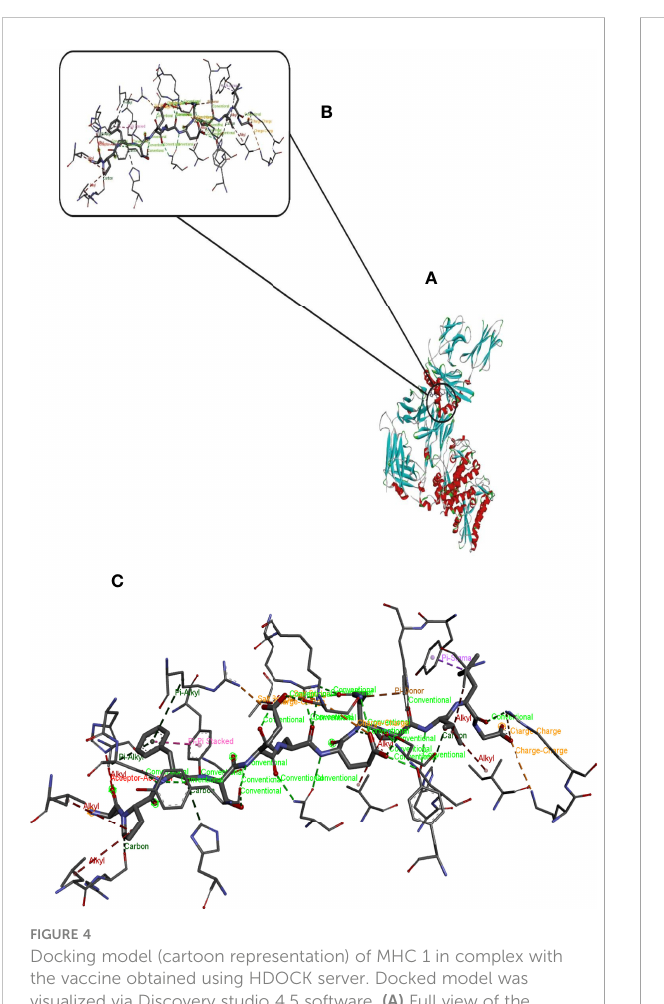
FIGURE 4 Docking model (cartoon representation) of MHC 1 in complex with the vaccine obtained using HDOCK server. Docked model was visualized via Discovery studio 4.5 software. (A) Full view of the docked model (B) Magni fi ed view of atomic interactions (C) Enlarged view of part (B) . FIGURE 5